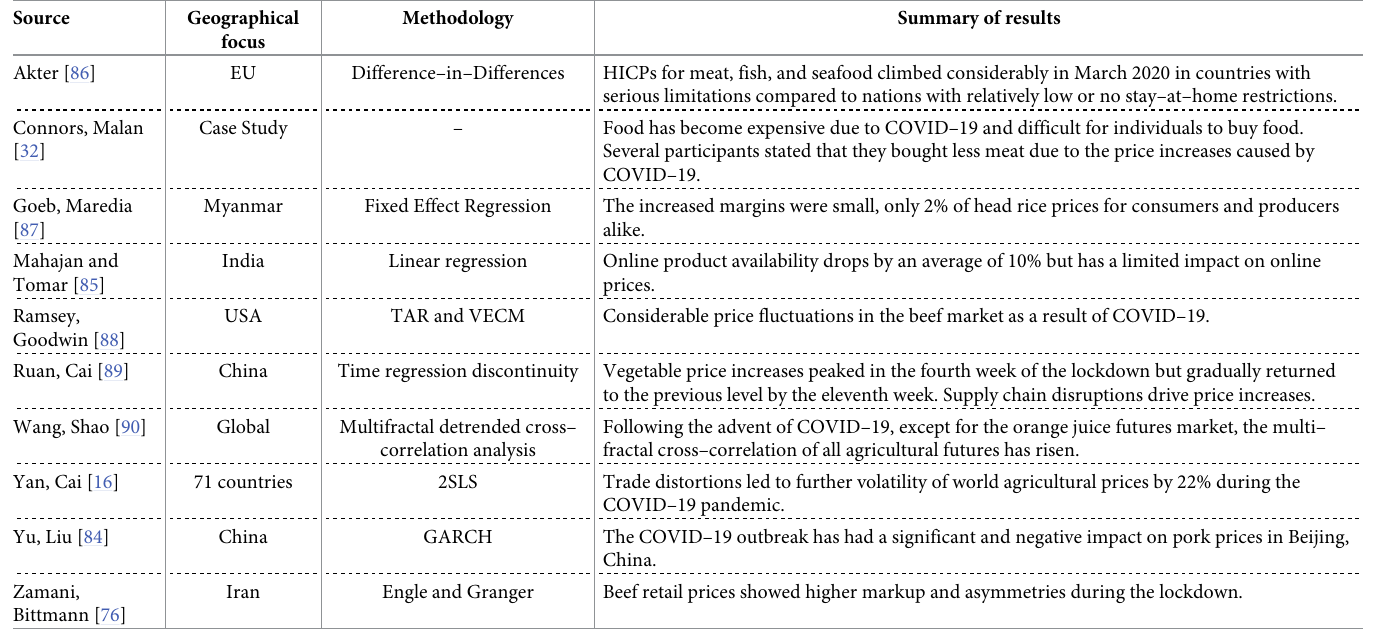
Table 1. Empirical studies of effects of COVID–19 on food